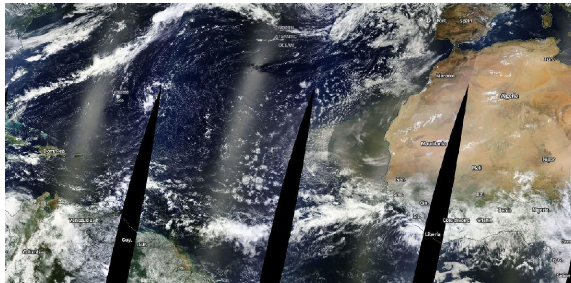
Figure A3. Dust storm on 7 August 2014.